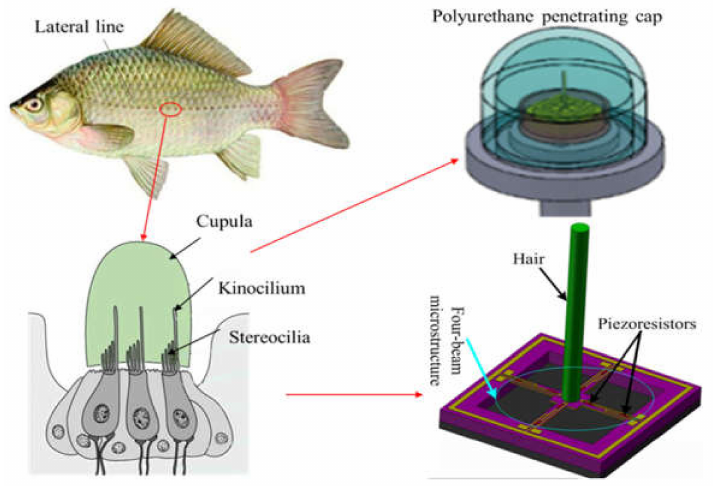
Figure 2. The bionic principles and micro-structural